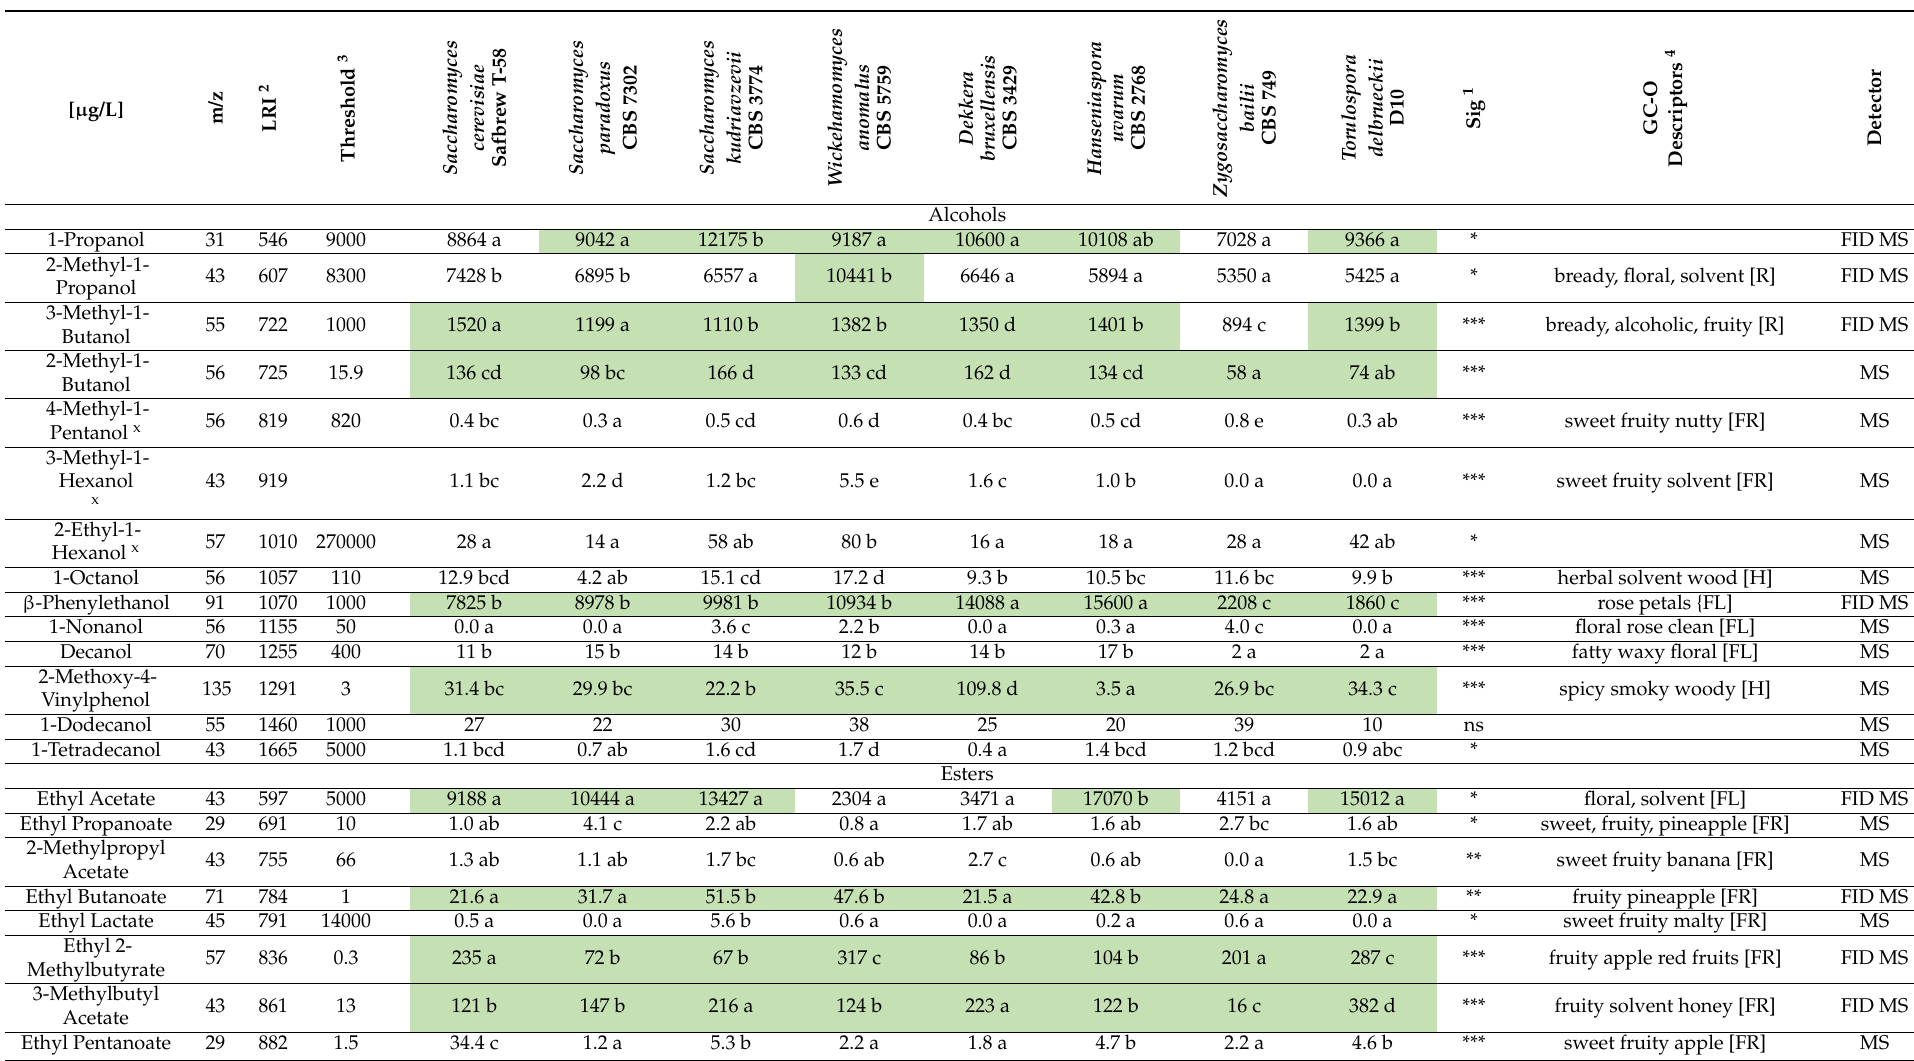
Table 3. Alcohols and esters in beers produced with different non-conventional